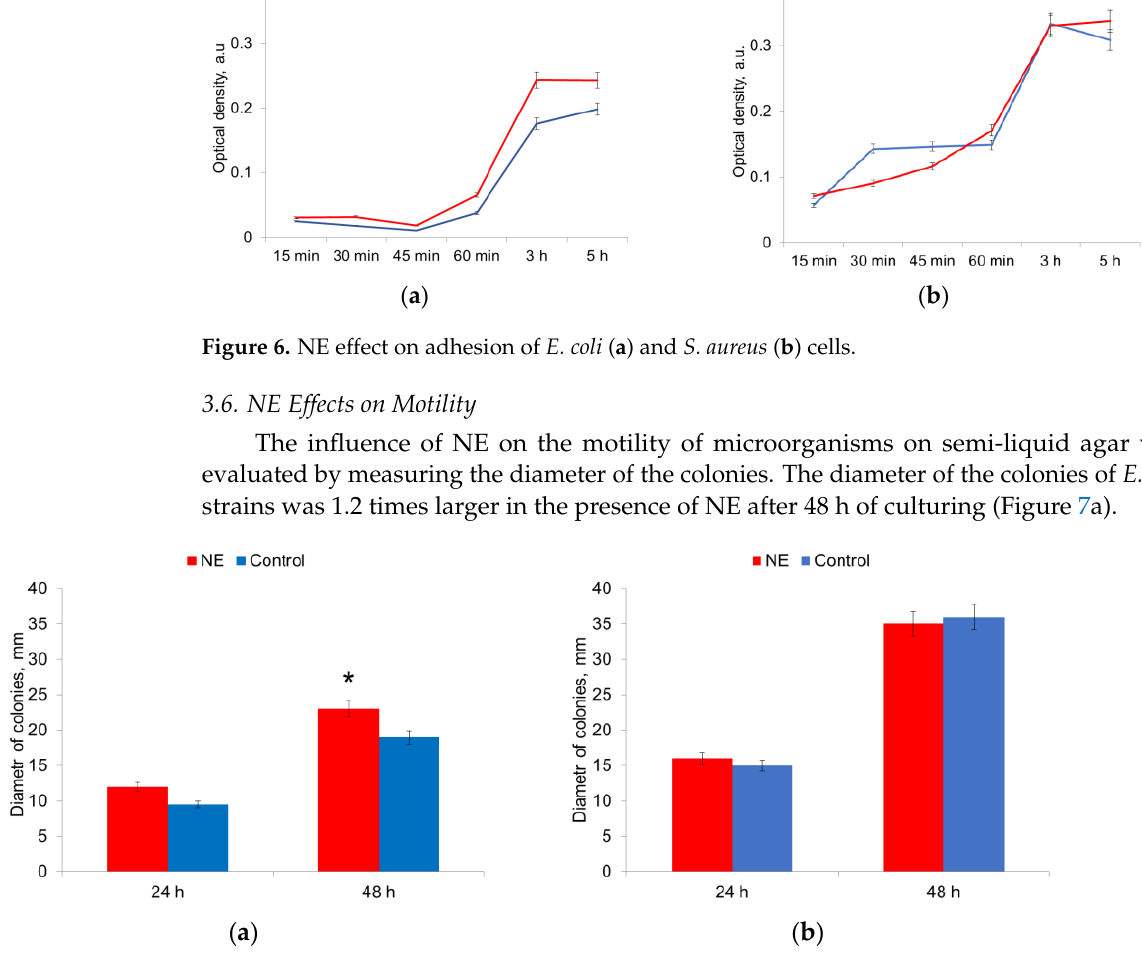
Figure 7. NE effect on motility of E. coli ( a ) and S. aureus ( b ) cells. * — statistically significant differences in comparison with the control without NE.